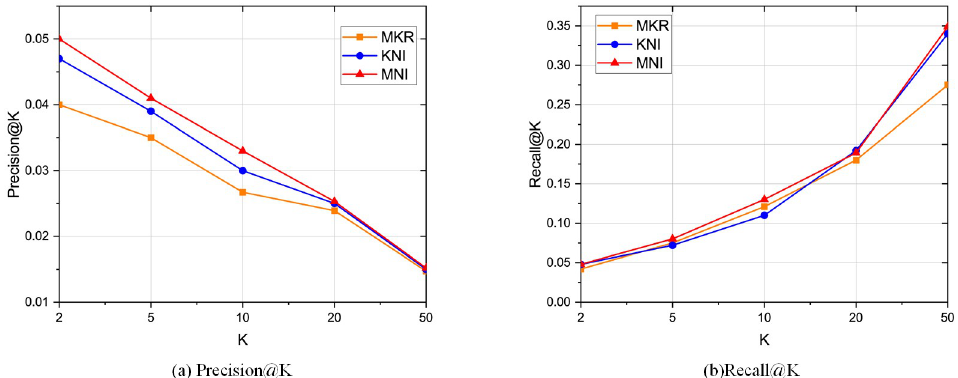
Fig 7. Top K recommendation result for Last-FM regarding precision and